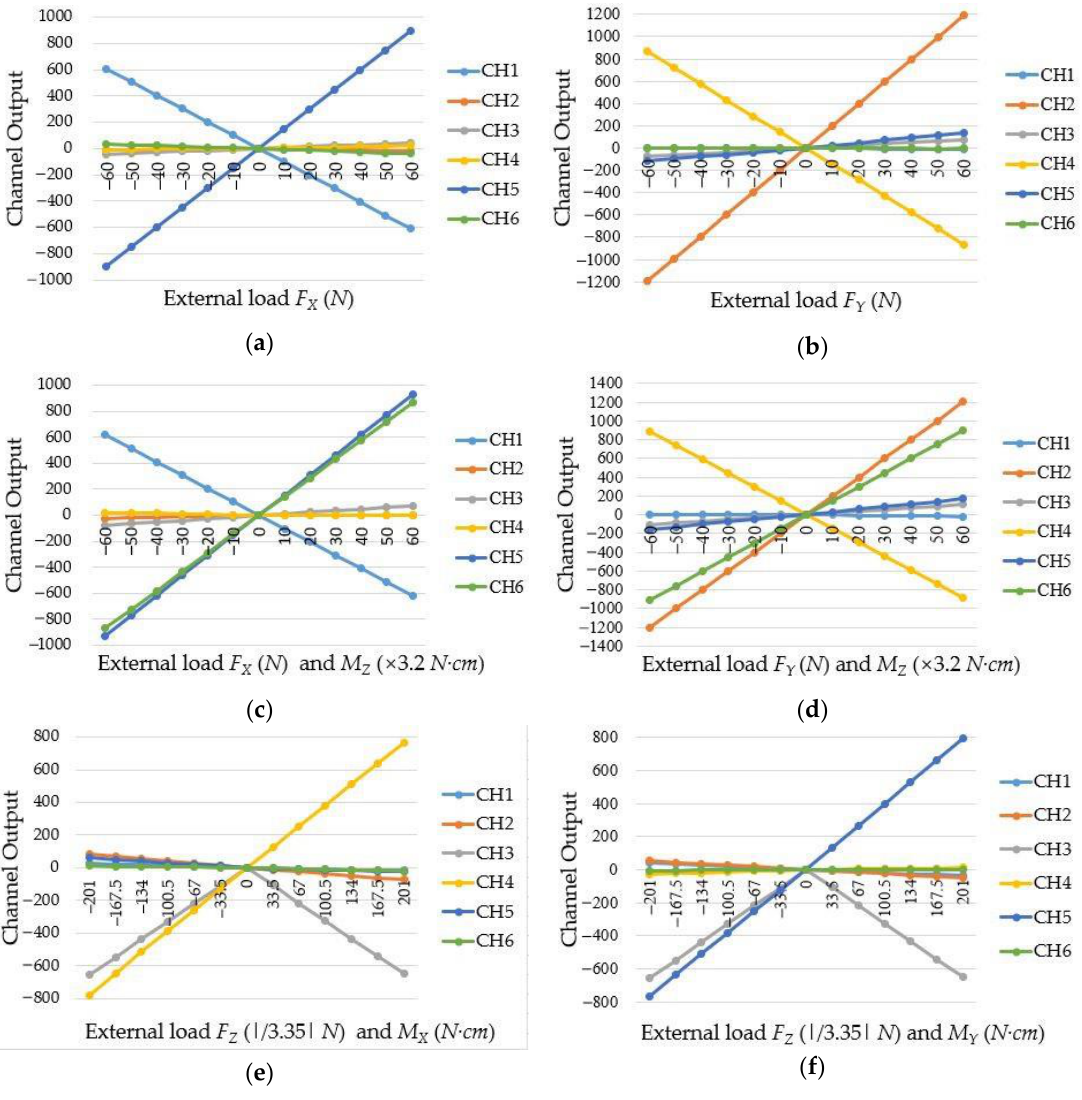
Figure 21. The output voltage changes of electric bridges: ( a ) under the force F X ; ( b ) under the force F Y ; ( c ) under the force F X and moment M Z ; ( d ) under the force F Y and moment M Z ; ( e ) under the force F Z and moment M X ; ( f ) under the force F Z and moment M Y .